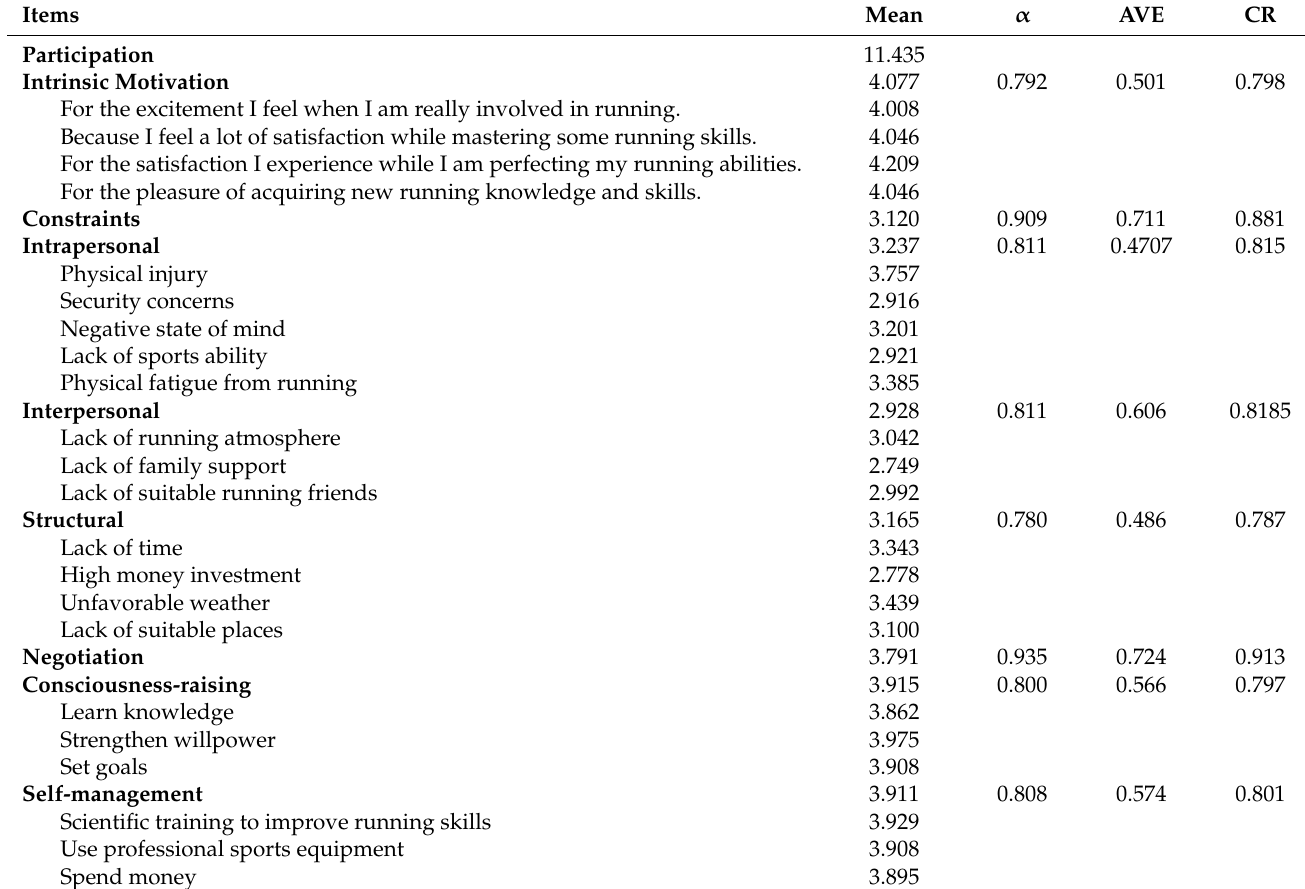
Table 1. Dimensions, items and statistics of constructs ( n =